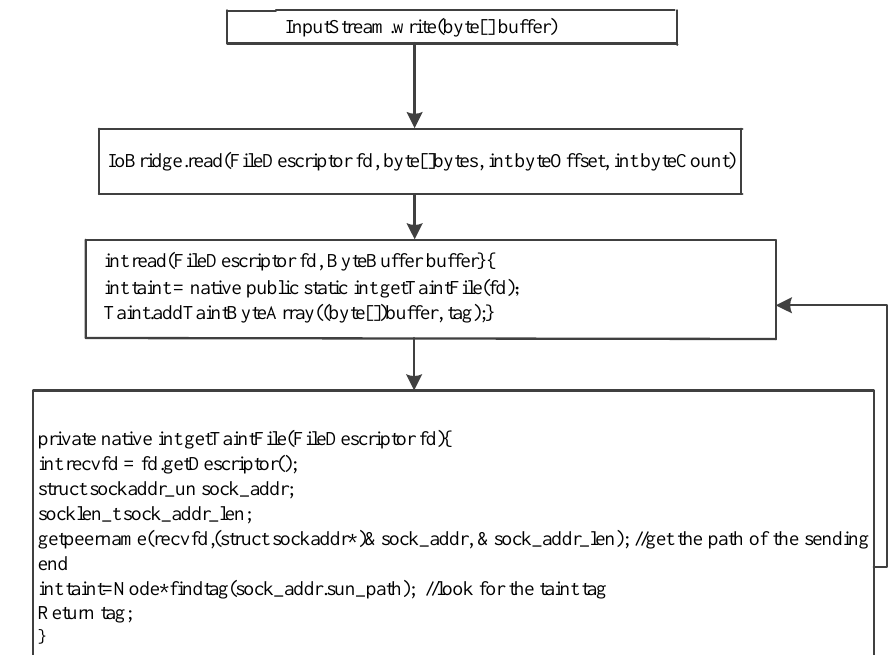
Figure 9. “read” taint operation.